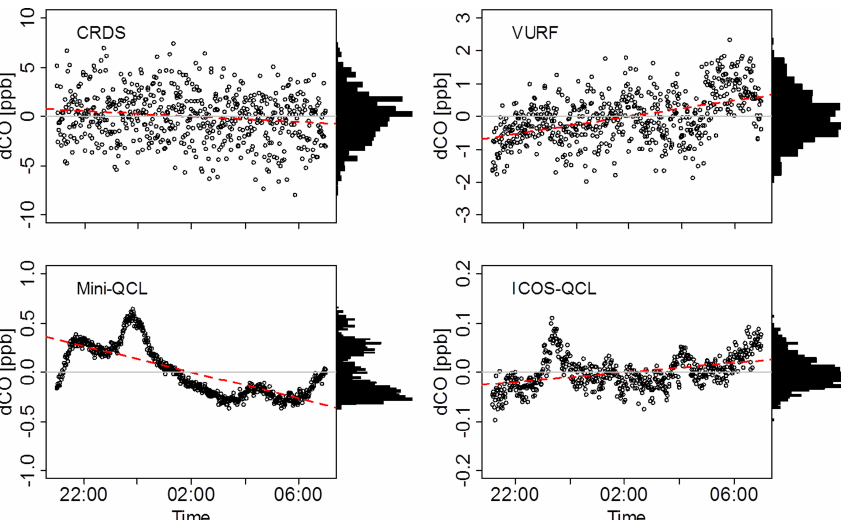
Fig. 2. Instrument drift over a 10-h period for 1-min data. The deviation from the mean value is shown for each data point. The red line depicts the linear regression line. The frequency distribution of individual measurement values is shown as a histogram on the right of each plot. Please take note of the different y-axis scales of the different panels.